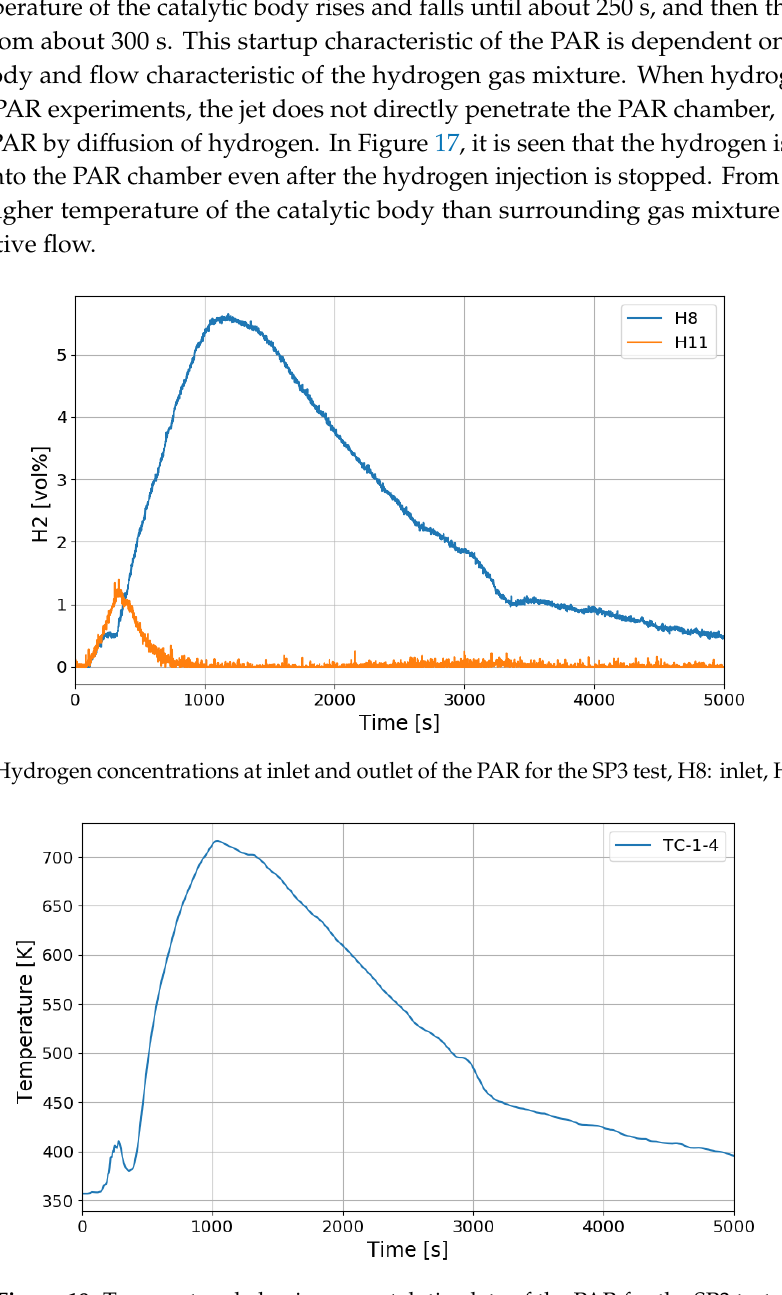
Figure 18. Temperature behaviors on catalytic plate of the PAR for the SP3 test.